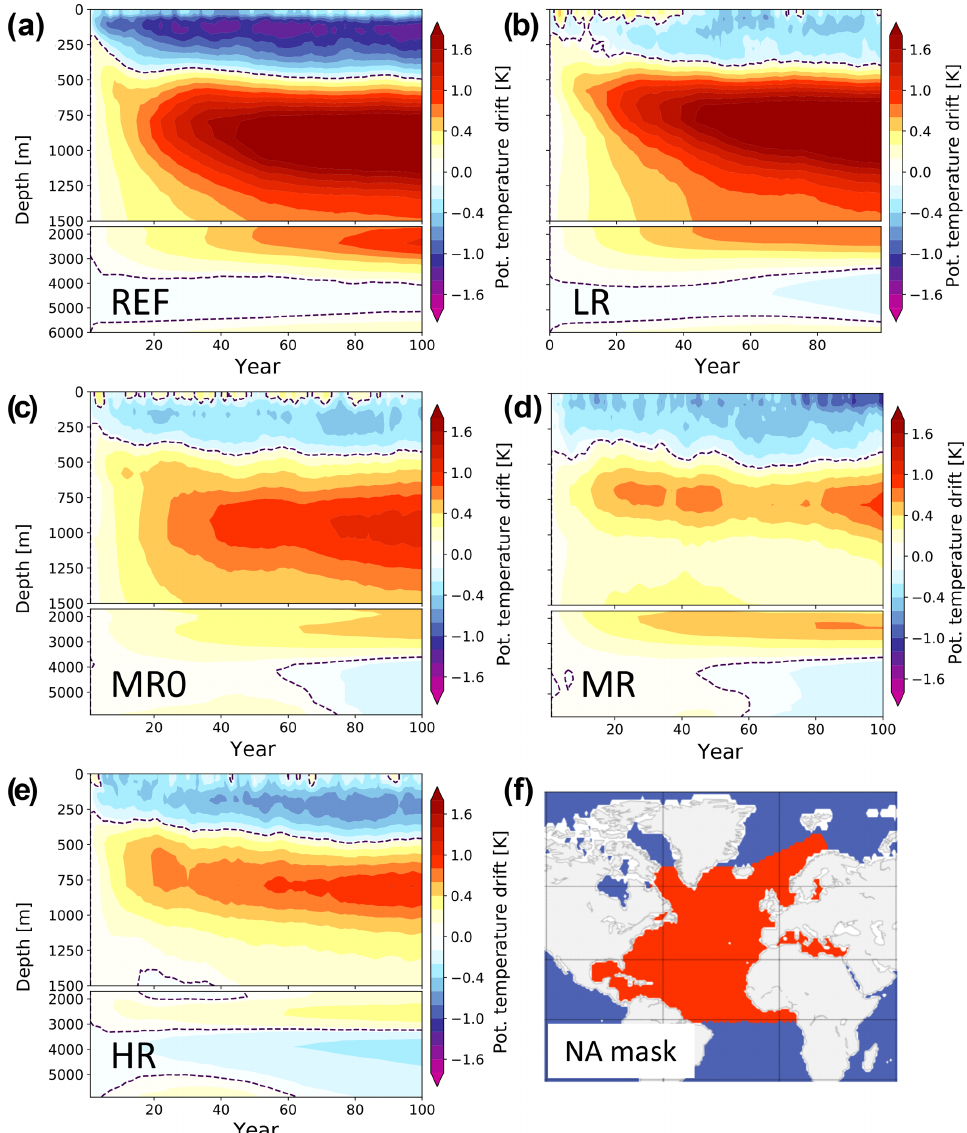
Figure 5. Time–depth Hovmöller diagram of the potential temperature drift [K] in the North Atlantic for (a–e) the five pre-industrial simu- lations. (f) Definition of the North Atlantic mask that was used in the Hovmöller